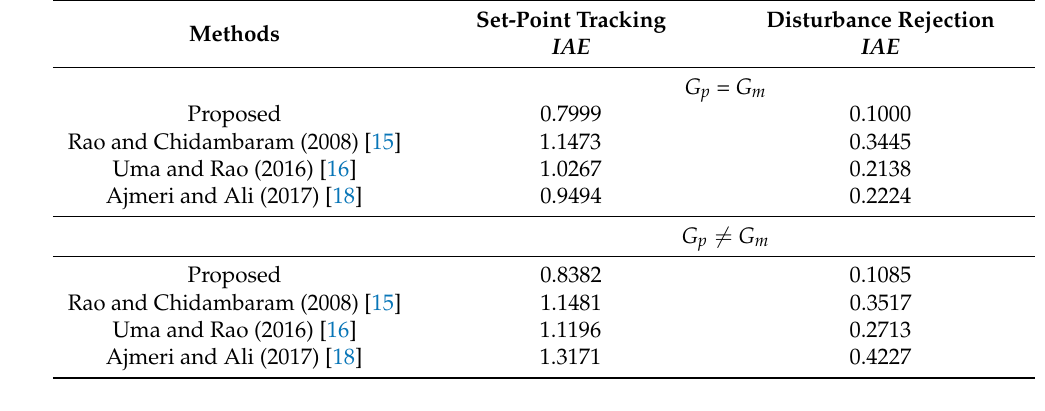
Figure 14. Control signals of the proposed method and other methods for Example 3 [15,16,18]. Table 7. IAE performance measures for Example 3. Table 7. IAE performance measures for Example 3.